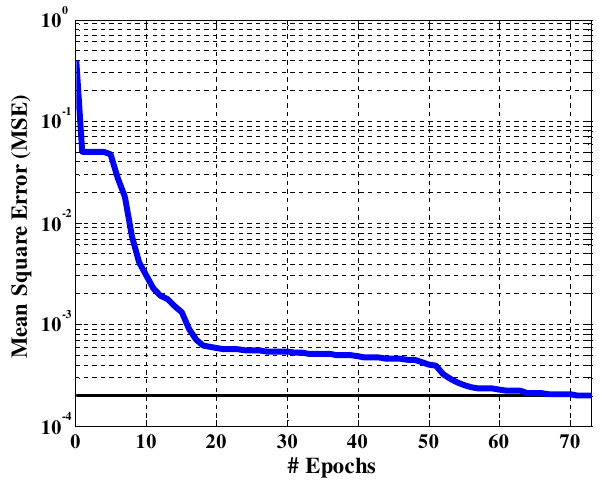
Fig. 8. Training curve for August.